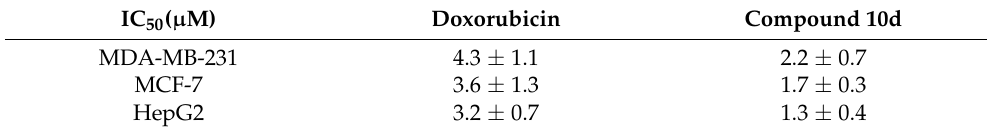
Figure 5. Chemical structures of doxorubicin N -acyl hydrazones derivatives ( 8 – 9 ). Table 2. IC 50 values of compound 10d against three cancer cell